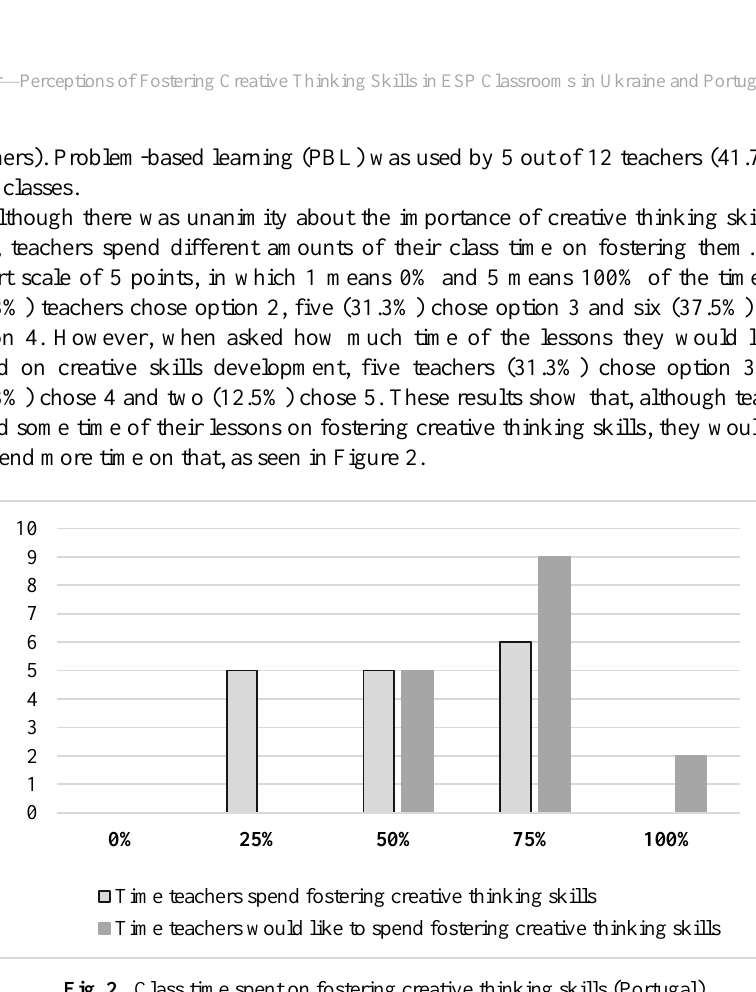
Fig. 2. Class time spent on fostering creative thinking skills